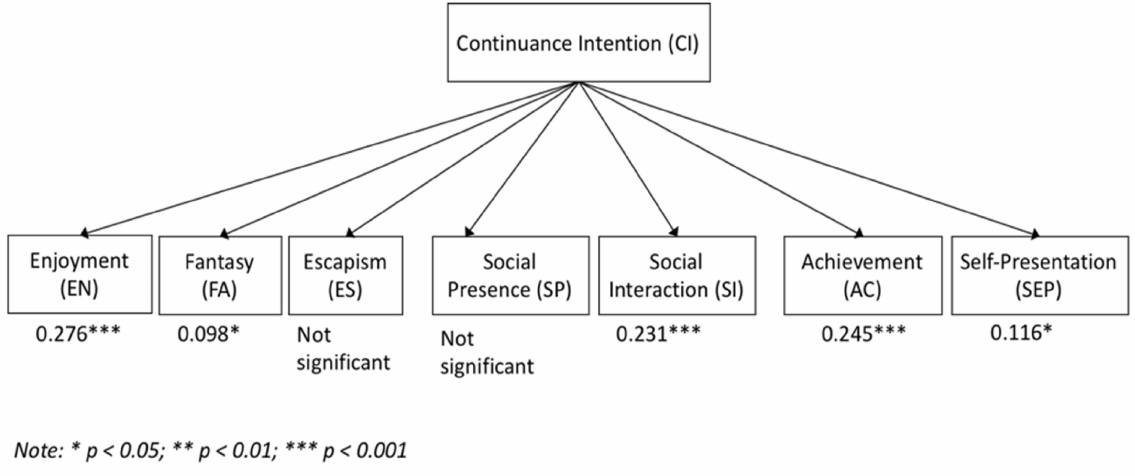
Fig. 2 Summary of inner model